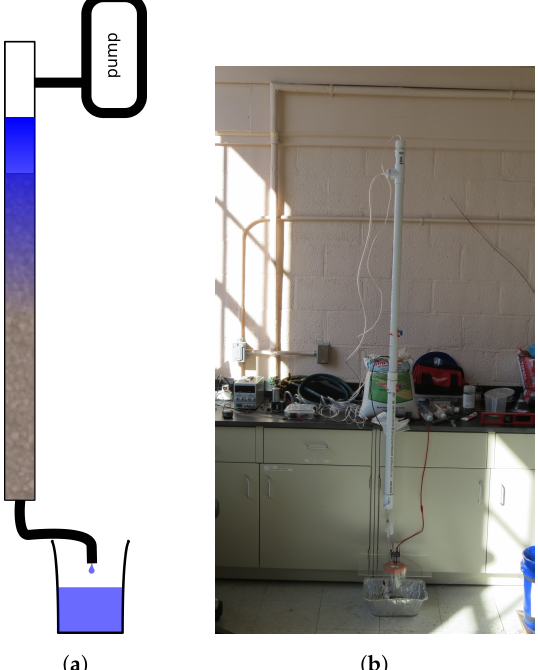
Figure 3. The experimental apparatus used to measure the movement of water through complex granular solids. The apparatus, shown schematically in ( a ), consists of a vertical test section filled with sand or soil. A volume of water is added above this granular material. The chamber can be sealed and held at pressure between 1 and 1.5 atm by a pump. Water that has passed through the soil or sand is expelled through tubing at the bottom of the section and collected in a beaker where its volume is measured at 10 Hz. ( b ) A photo showing the actual apparatus configured as used in the reported